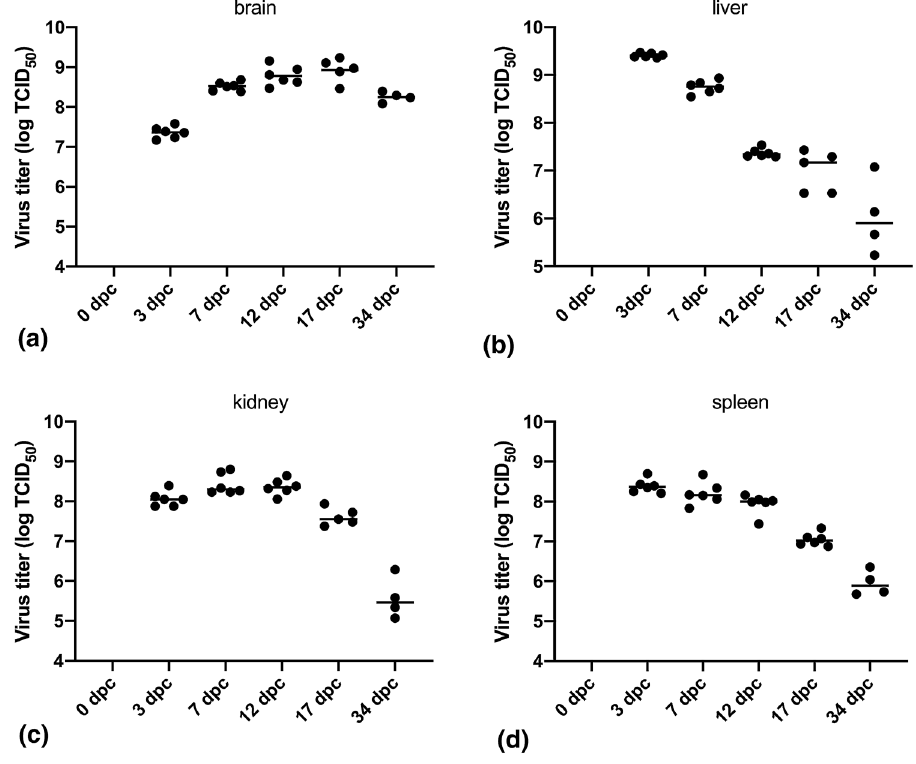
Figure 2. ( a – d ) Virus titers in the different organs shown for individual fish over the course of